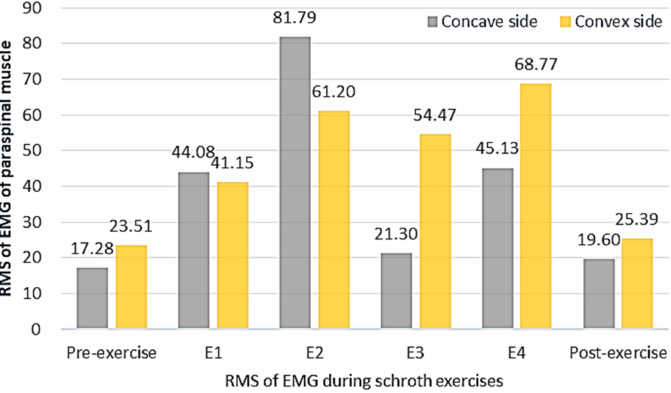
Figure 3. The RMS of sEMG before, during, and after the Schroth exercise ( n = 9). The highest RMS concave (81.79 µ V) was observed in E2, which was a symmetric exercise against gravity and induced muscle contraction on both sides. The highest RMS convex (68.77 µ V) was observed in E4, which was an asymmetric exercise, with side bending to the convex side and stretching of the concave side. Upon comparing the magnitude of sEMG activity of paraspinal muscles, this study observed that E4 > E3 ( p < 0.05) and E2 > E1 ( p < 0.05) in both the convex and concave side of the scoliotic